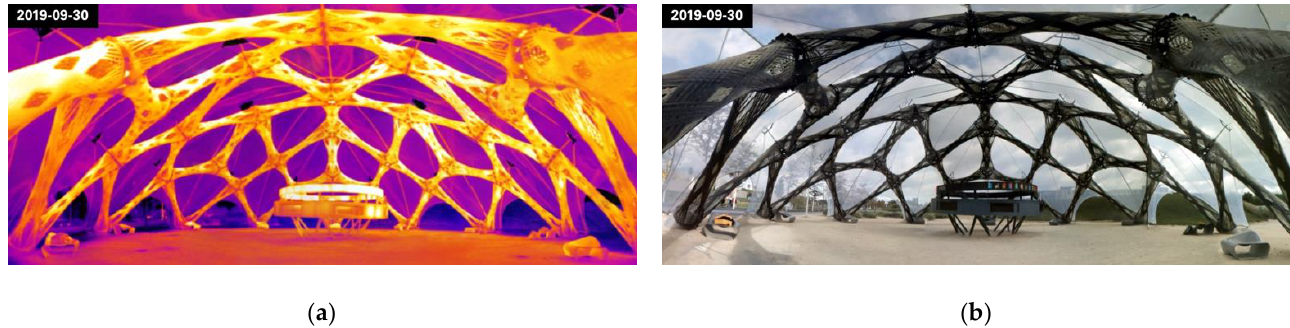
Figure 6. Stitched panoramic pictures of the BUGA Fiber Pavilion. Sun position towards the right side of the picture: ( a ) infrared spectrum (scale 10.0 – 23.0 °C); ( b ) visual spectrum.